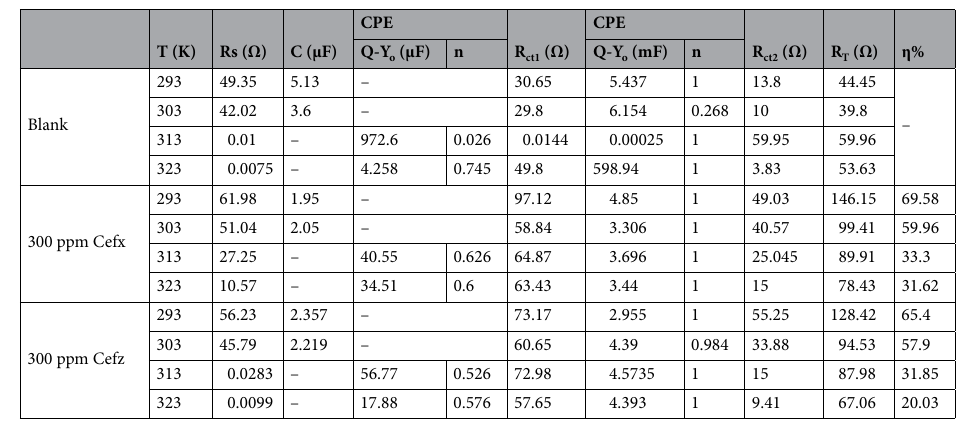
Table 4. Electrochemical parameters and inhibition efficiencies of Al in 0.1 M NaOH solution based on EIS measurements in the absence and presence of 300 ppm of Cefx and Cefz drugs at different